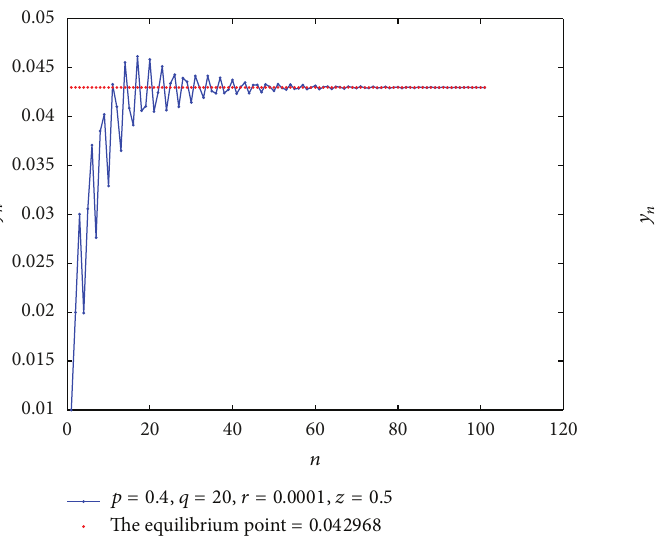
Figure 1: Dynamics of 𝑦 𝑛+1 = (0.0001 + 0.4𝑦 𝑛 + 𝑦 𝑛−2 )/(0.5 + 20𝑦 𝑛 + ) . 𝑦 𝑛−2